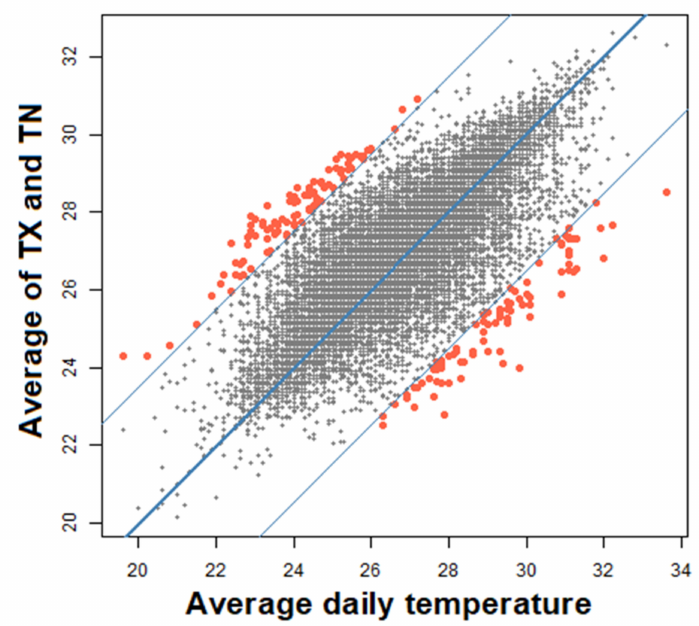
Figure 14. Result of the consistency test for the average daily temperature. The red dots represent values for which the difference between the daily average temperature and the average between maximum and minimum temperatures exceeded the 99%